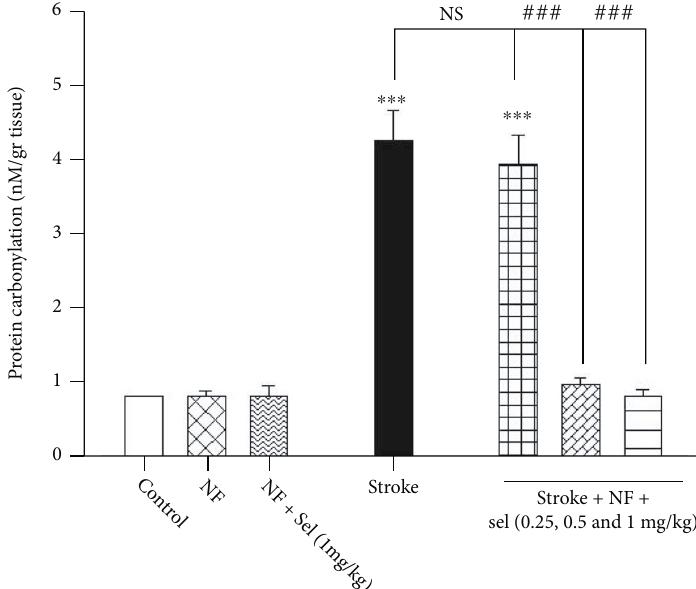
Figure 10: E ff ects of selegiline on protein carbonylation level in the brain. Values are expressed as the mean ± SD and were analyzed using one-way ANOVA followed by Tukey ’ s post hoc test ( n = 3 ). ∗ P < 0 : 05 , ∗∗ P < 0 : 01 , and ∗∗∗ P < 0 : 001 compared with control group. # P < 0 : 05 and ## P < 0 : 01 and ### P < 0 : 001 compared with transient global ischemia rats. “ NF = nanoformulated containing NBP; NF+sel = nanoformulated containing NBP+selegiline.